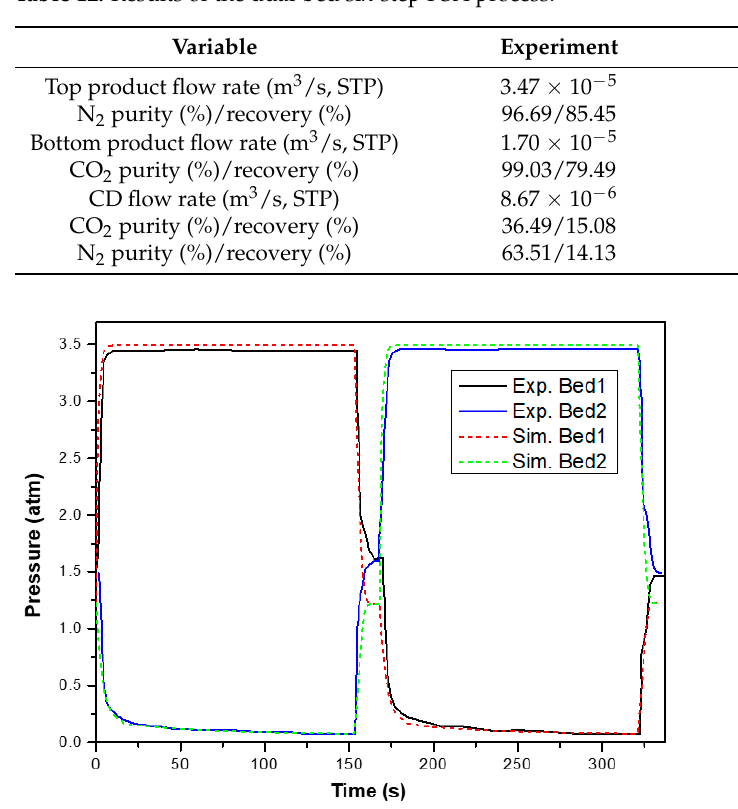
Figure 10. Pressure profile of the dual-bed six-step PSA experiment and simulation.